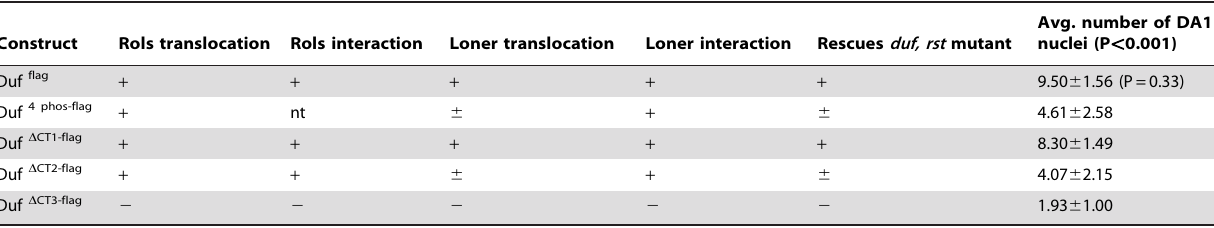
Table 1. Summary of Duf intracellular domain